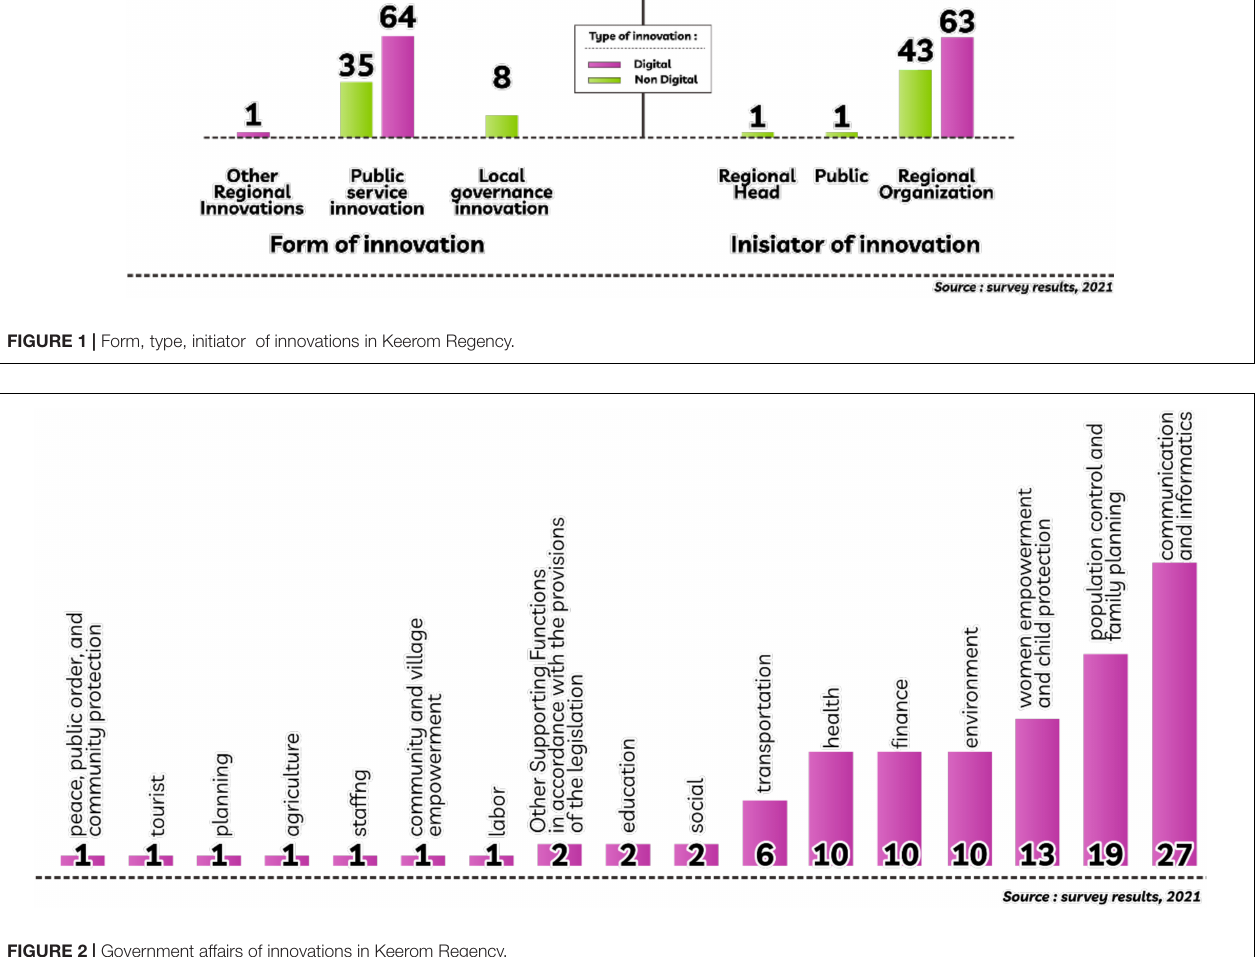
FIGURE 2 | Government affairs of innovations in Keerom